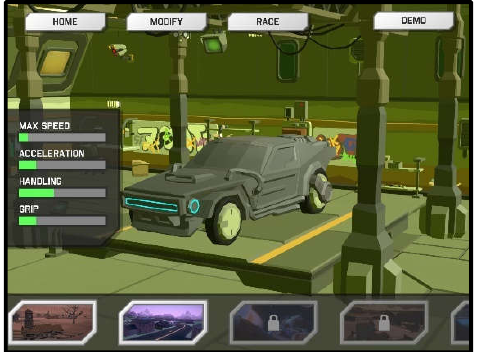
Figure 8. Garage scene.